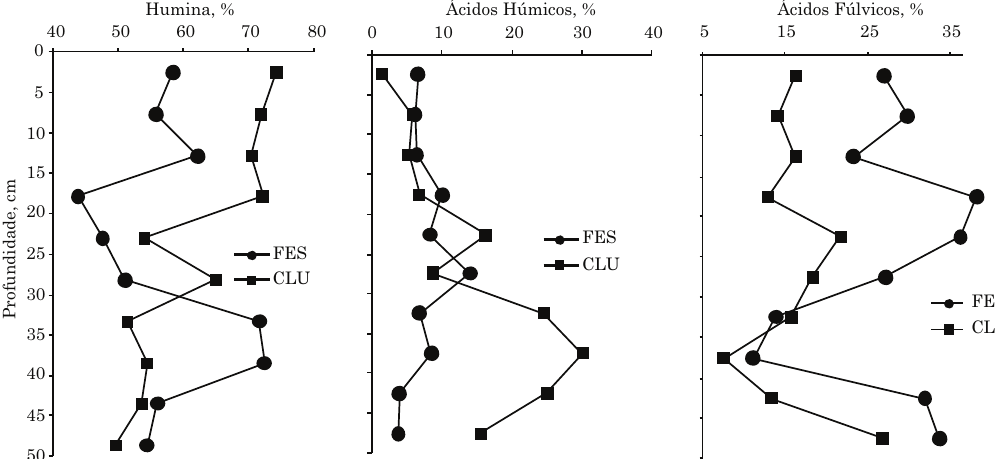
Figura 1. Teores médios de humina, ácidos húmicos e ácidos fúlvicos (% MOS), em profundidade no Campo Limpo Úmido (CLU) e na Floresta Estacional Semidecidual